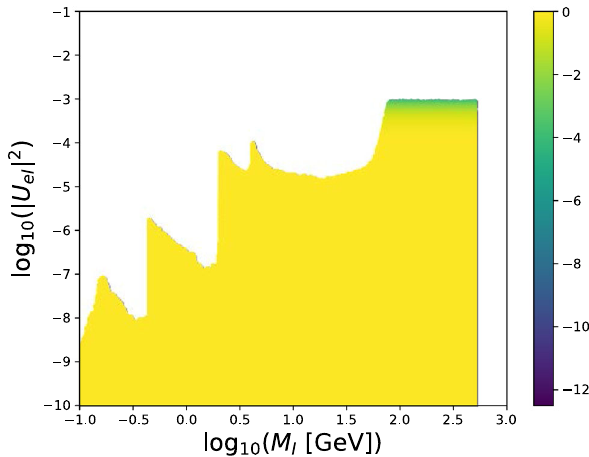
Fig. 24 Partial likelihood from sin θ W , in the M I − | U eI | 2 plane